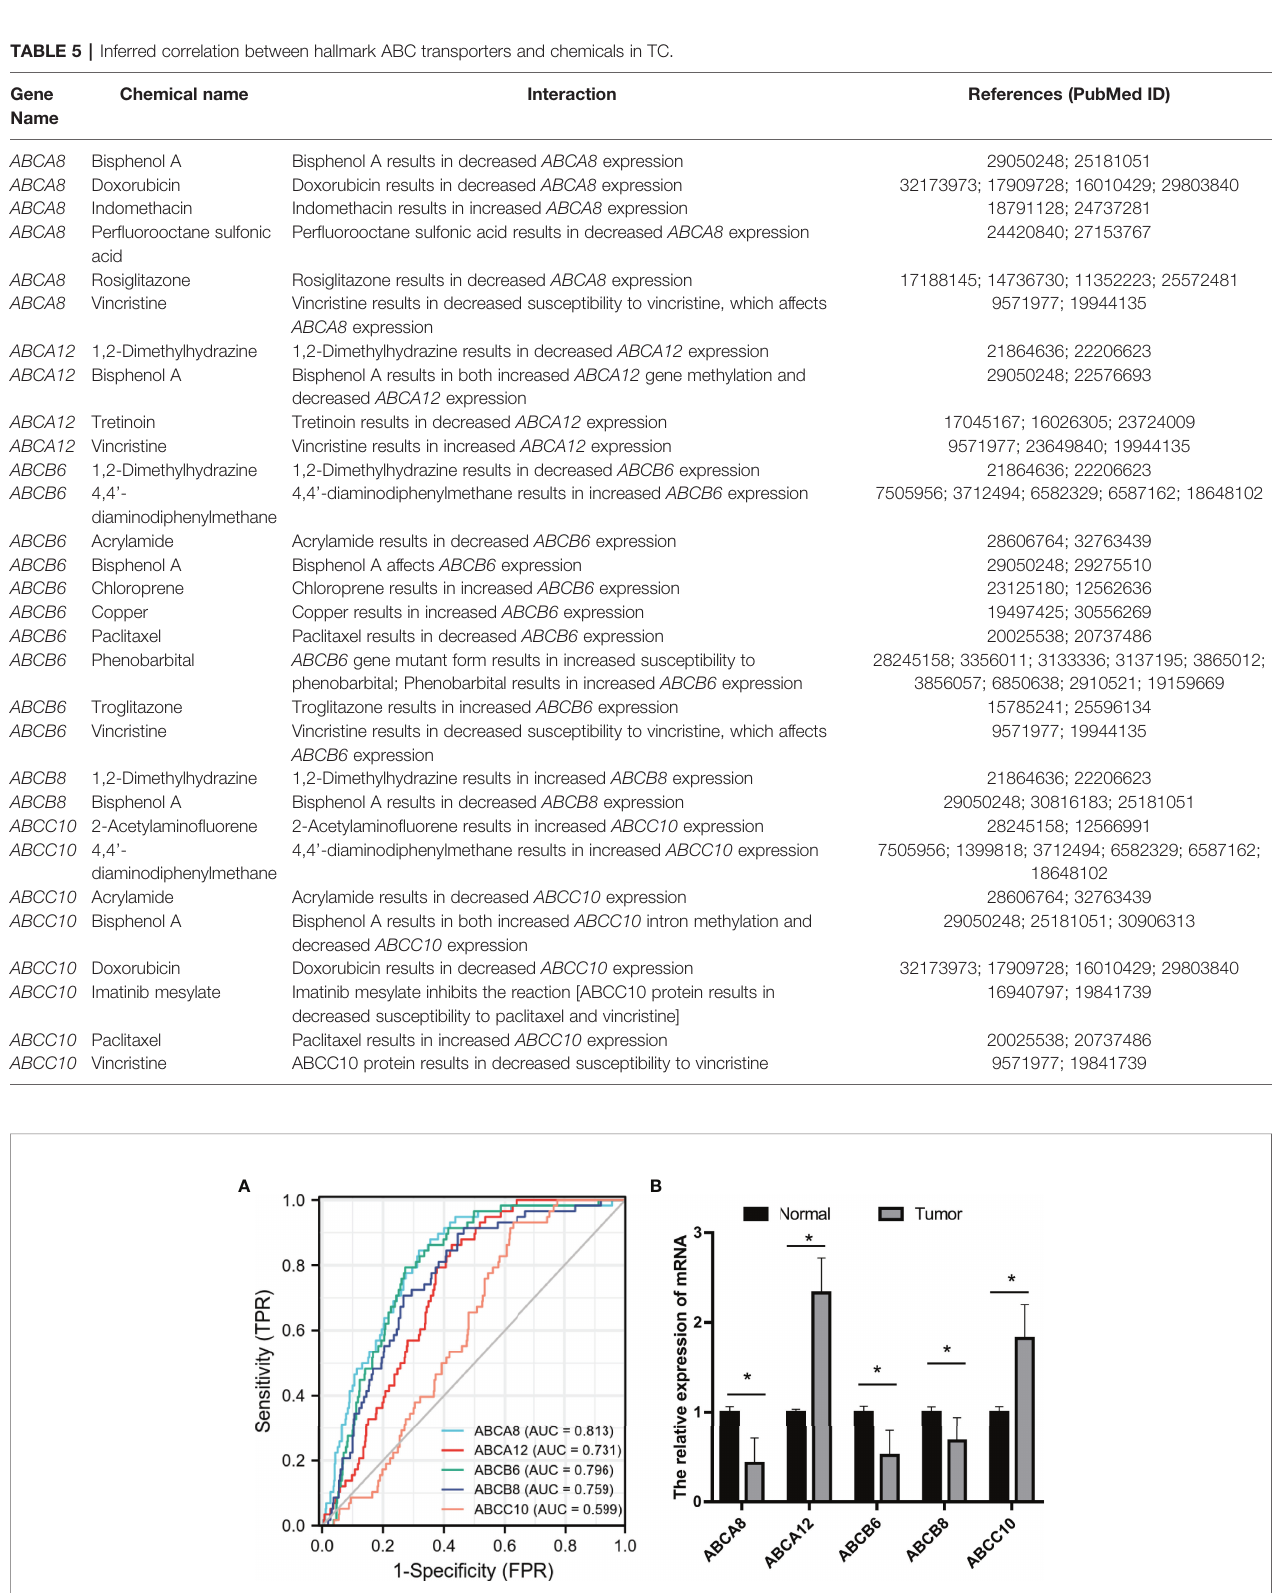
FIGURE 8 | Prognostic prediction value and validation of the fi ve hallmark ABC transporters in TC. (A) The ROC curves of the fi ve hallmark ABC transporters in TC. (B) Relative mRNA expression of the fi ve hallmark ABC transporters in TC and normal thyroid tissues. FPR, false positive rate; TPR, true positive rate. * P <